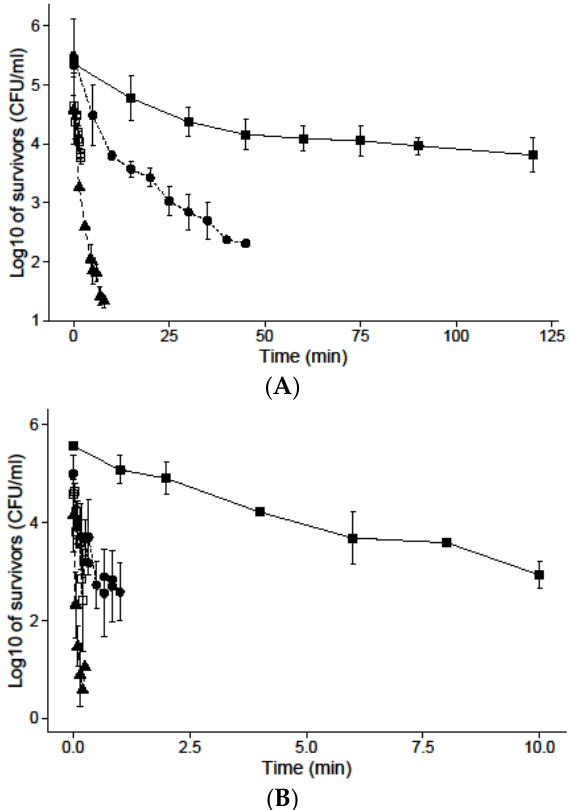
Figure 1. Survival curves of S. Senftenberg in Tryptic Soy Broth (TSB) at 50 °C ( A ) and 55 °C ( B ) with 0 (closed squares), 0.1 (circles), 0.5 (open squares) and 1 (triangles) mM D -limonene nanoemulsified.